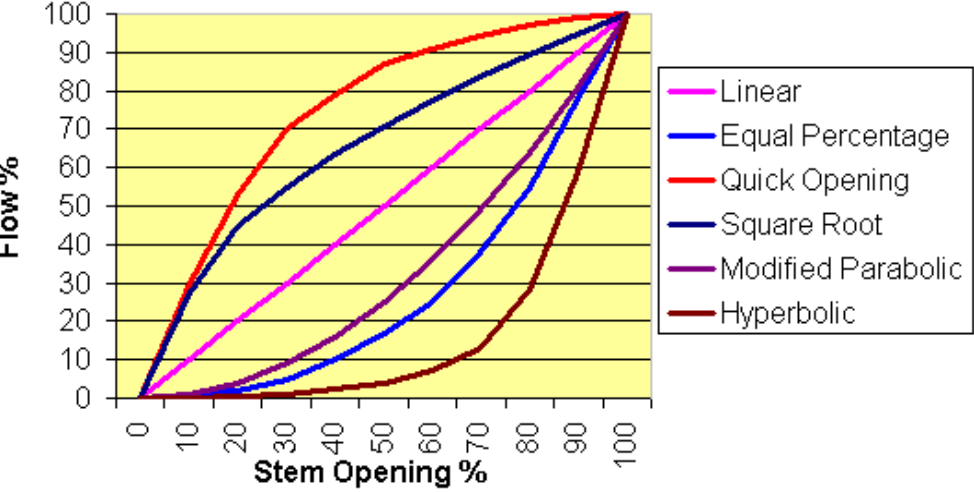
Figure 2. Typical inherent valve characteristics [16].